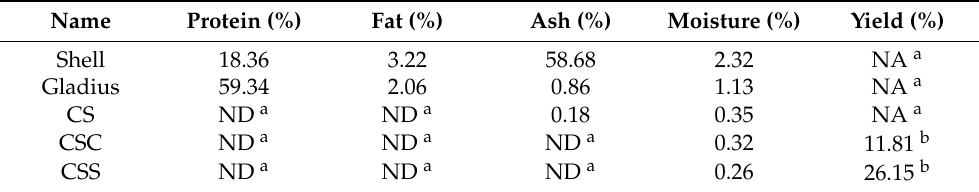
Table 1. Proximate composition of the dried shell of Portunus trituberculatus and squid gladius of Illex argentinus